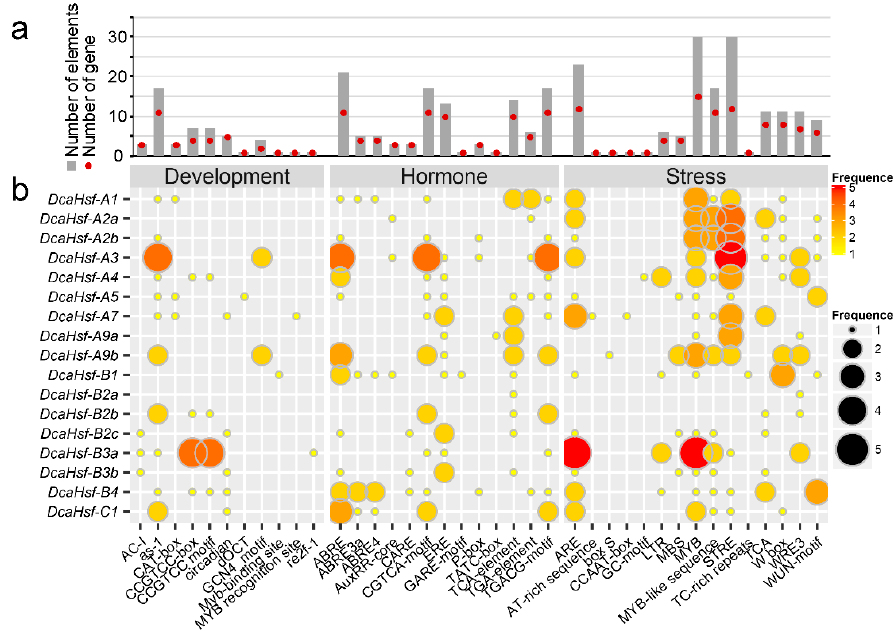
Figure 4. Cis -regulatory elements in the promoter region of DcaHsfs . ( a ) Number of each cis -acting element in the promoter region (1.5 kb upstream of the translation initiation site) of DcaHsfs . Statistics of the total number of DcaHsfs including the corresponding cis -acting elements (red dot) and the total number of cis -acting elements in the DcaHsf gene family (gray box). ( b ) Frequency of the cis -acting elements in each gene. Based on the functional annotation, the cis -acting elements were classified into three major classes: stress-, hormone-, and development-related cis -acting elements.